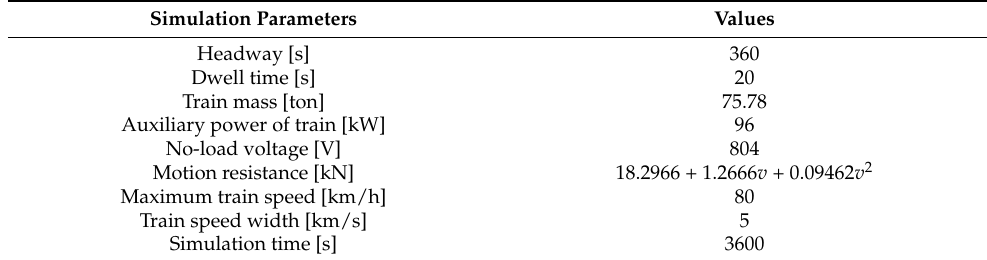
Table 1. Simulation parameters for TPS and DCPS.